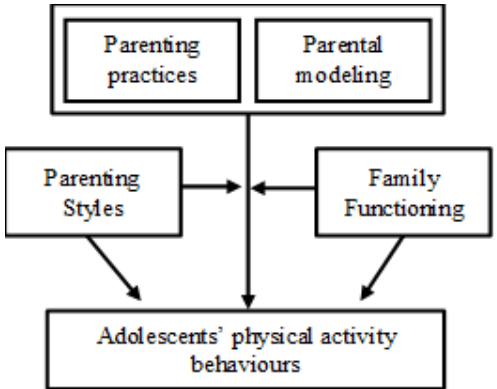
Figure 1. Theoretical model testing how parenting and family factors relate to adolescents’ physical activity behaviours. 104